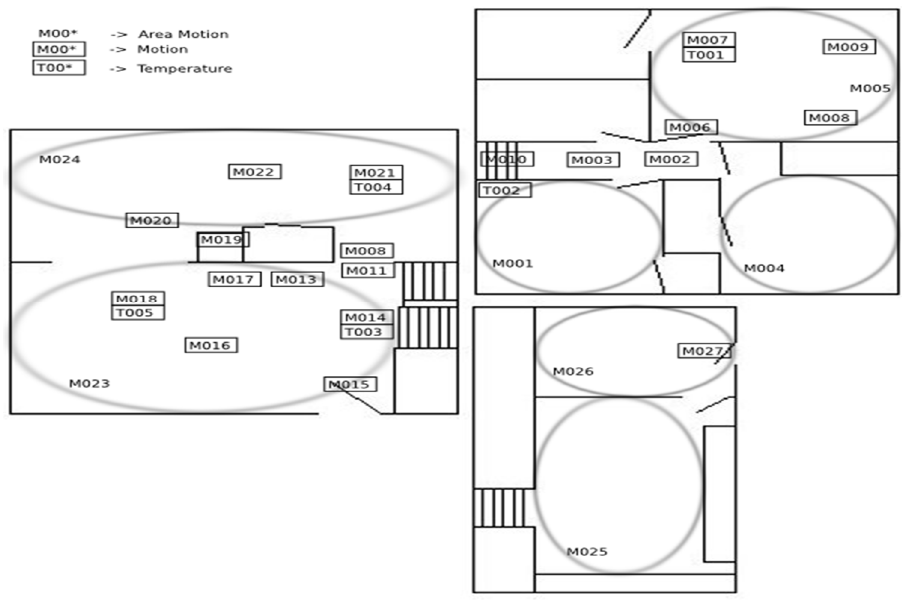
Figure 3. Cairo sensor layout.